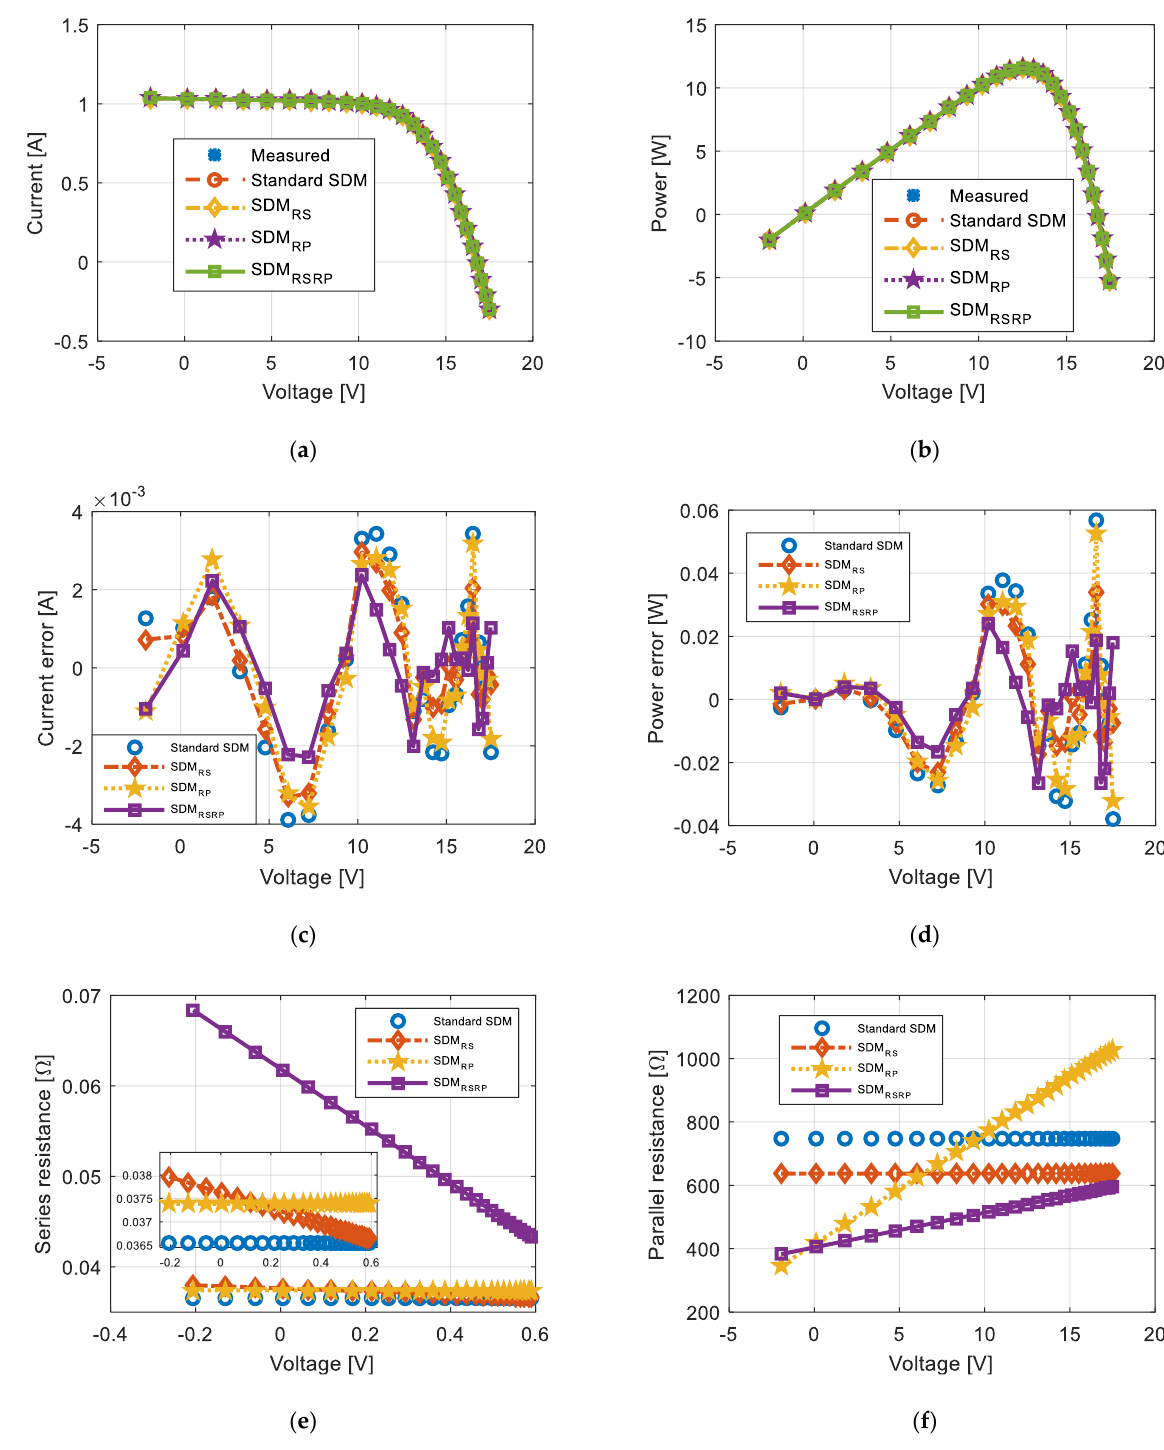
Figure 10. Photowatt-PWP201 module: ( a ) current-voltage characteristics; ( b ) power-voltage characteristics; ( c ) corresponding current-voltage errors; ( d ) corresponding power-voltage errors; ( e ) series resistance – voltage dependence characteristics; ( f ) parallel resistance – voltage dependence characteristics. Table 4. Wilcoxon test